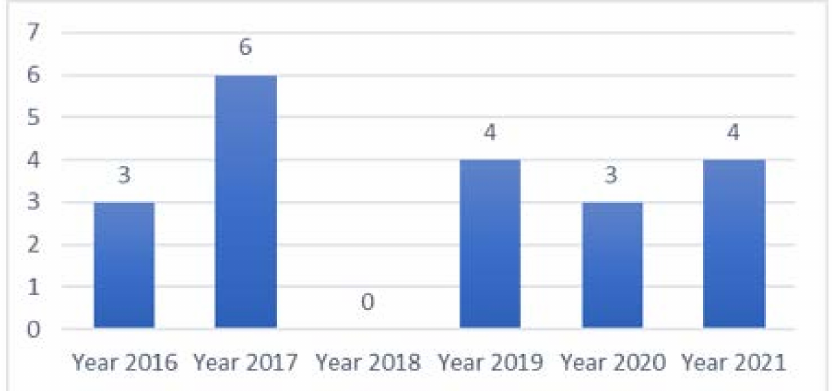
Figure 2. The number of reviewed papers since